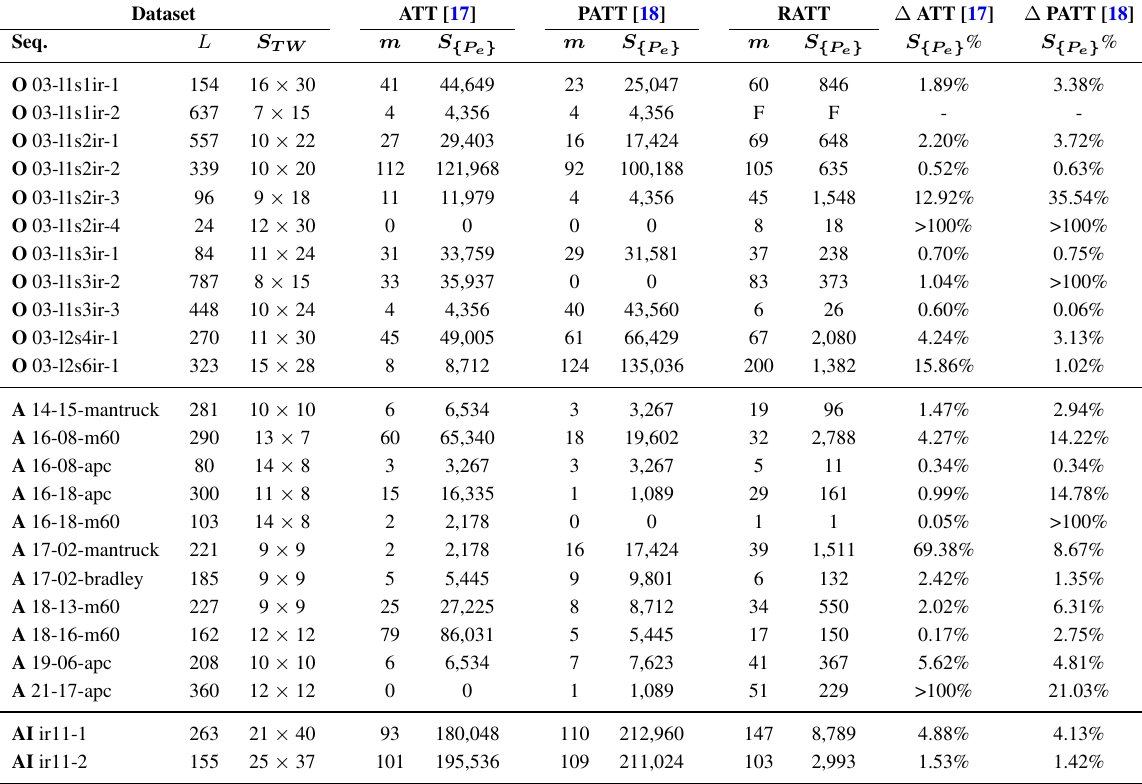
Table 2. Comparison of the number of activations m of the TM phase and the number of evaluated points S among the proposed algorithm and the reference ones, ATT { P e }